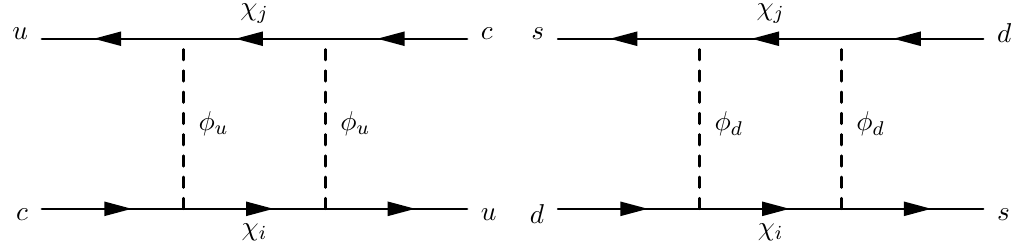
Figure 3 . New one loop contribution to D 0 (cid:0) (cid:22) D 0 (left) and K 0 (cid:0) (cid:22) K 0 mixing (right). Analogous contributions to B 0